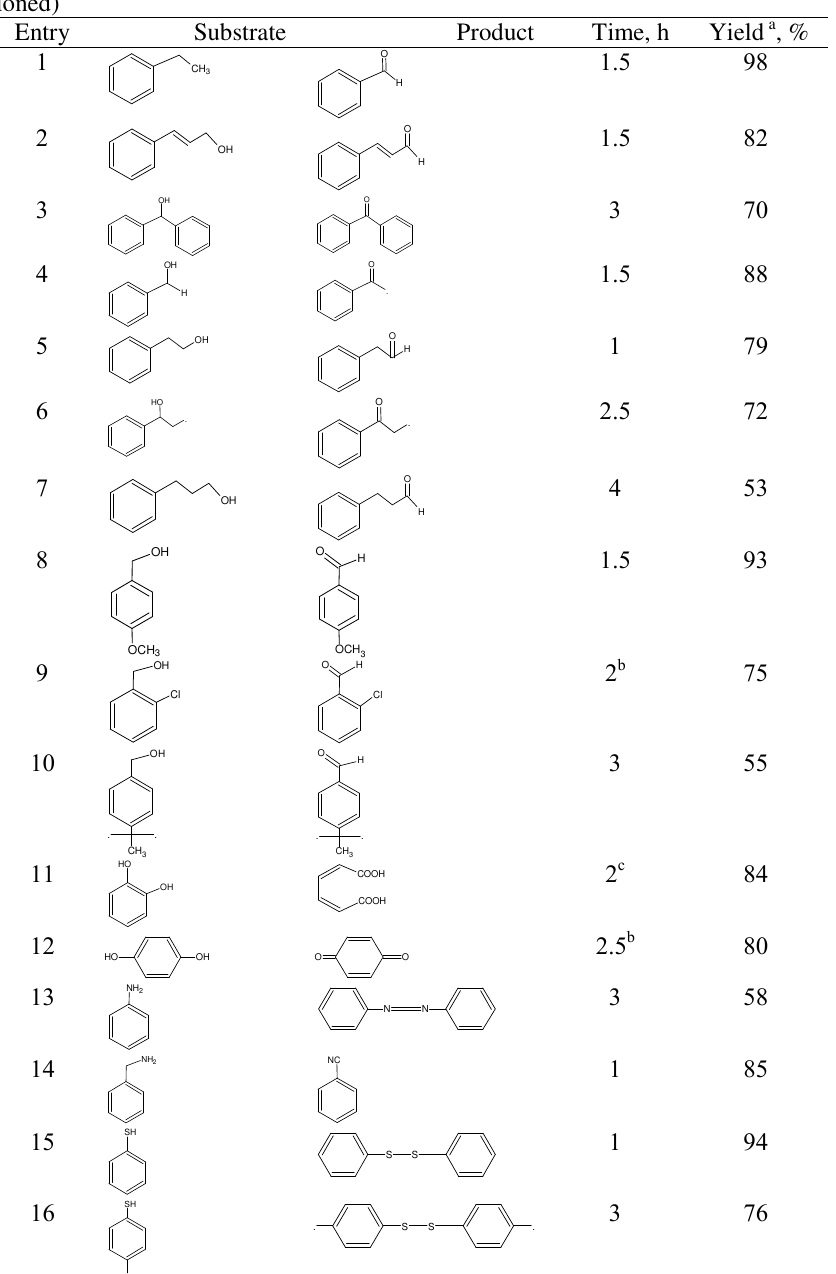
Table 2 . Oxidation of some organic compounds with NiO